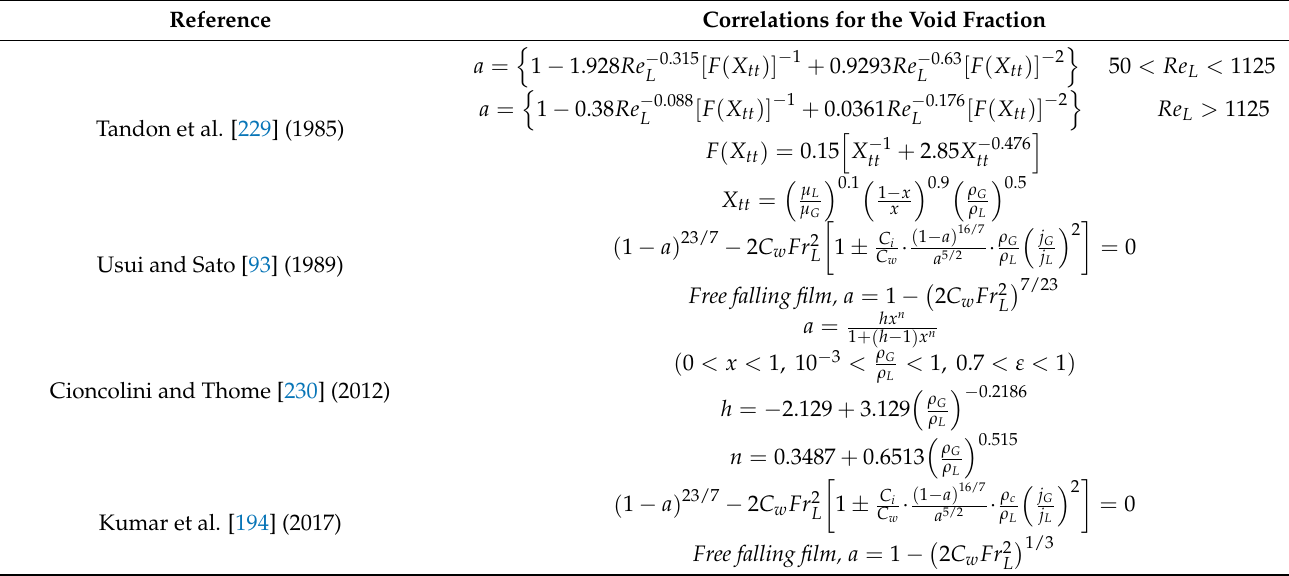
Table 2. Correlations for the void fraction (a) of annular two-phase flows.